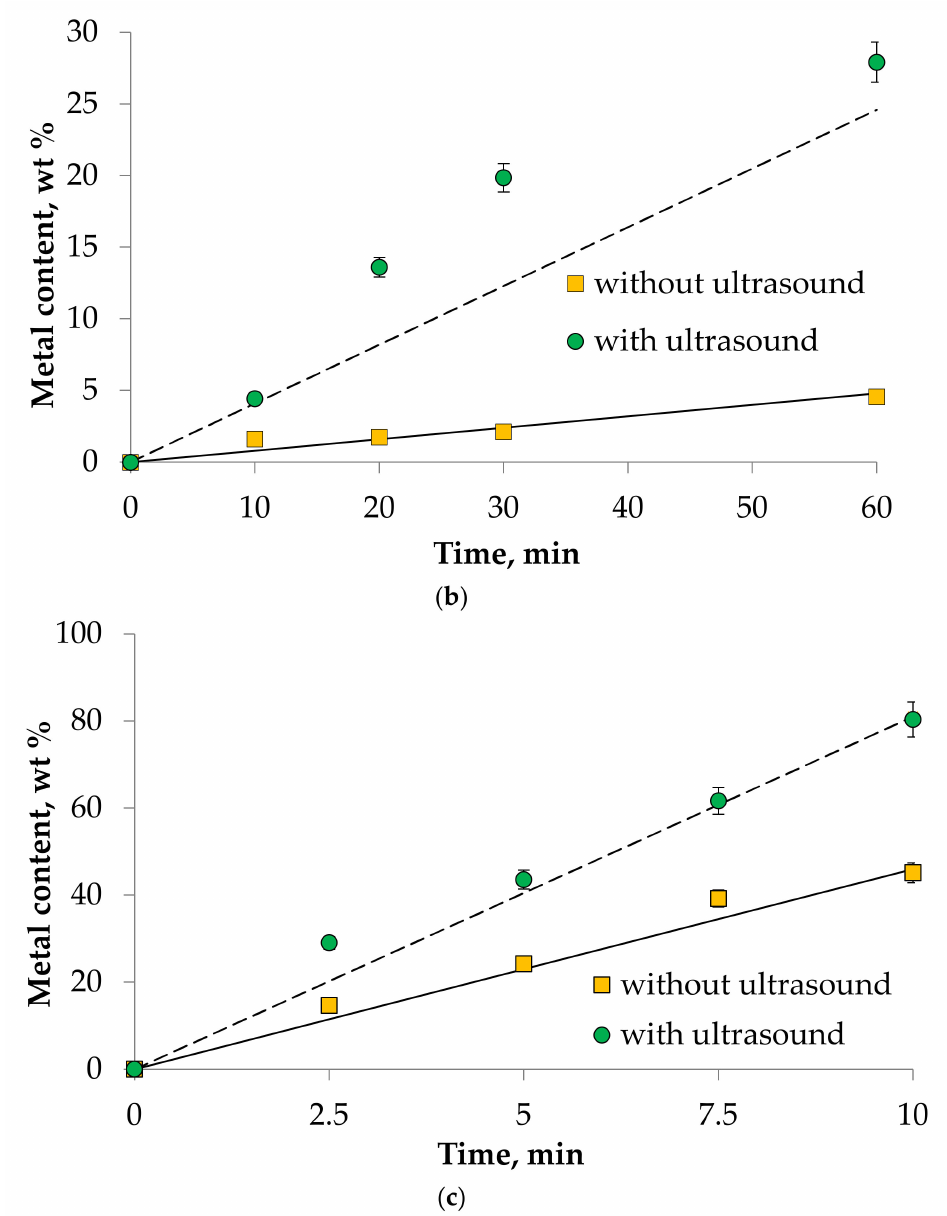
Figure 5. Metal oxides dissolution kinetics (Mn(III)—( a ), Ni(III)—( b ), Co(II)—( c ) in choline chlo- ride/sulfosalicylic acid (7:3) as a deep eutectic solvent: lines—theory, markers—experiment.